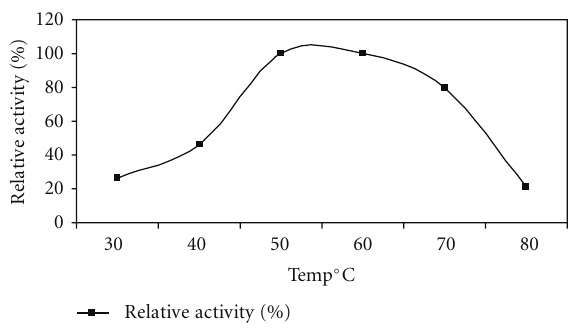
Figure 5: Double reciprocal plot for determining the V max and Km values of xylanase Bacillus arseniciselenatis DSM 15340 when acted on Birchwood xylan.